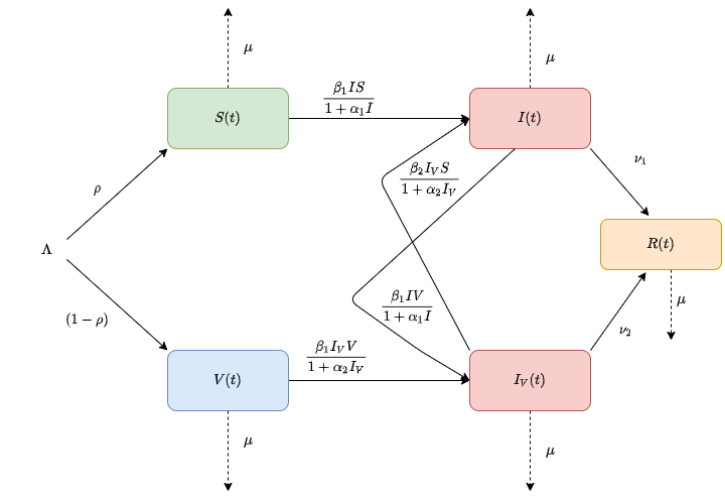
Figure 1. The flow diagram of the model